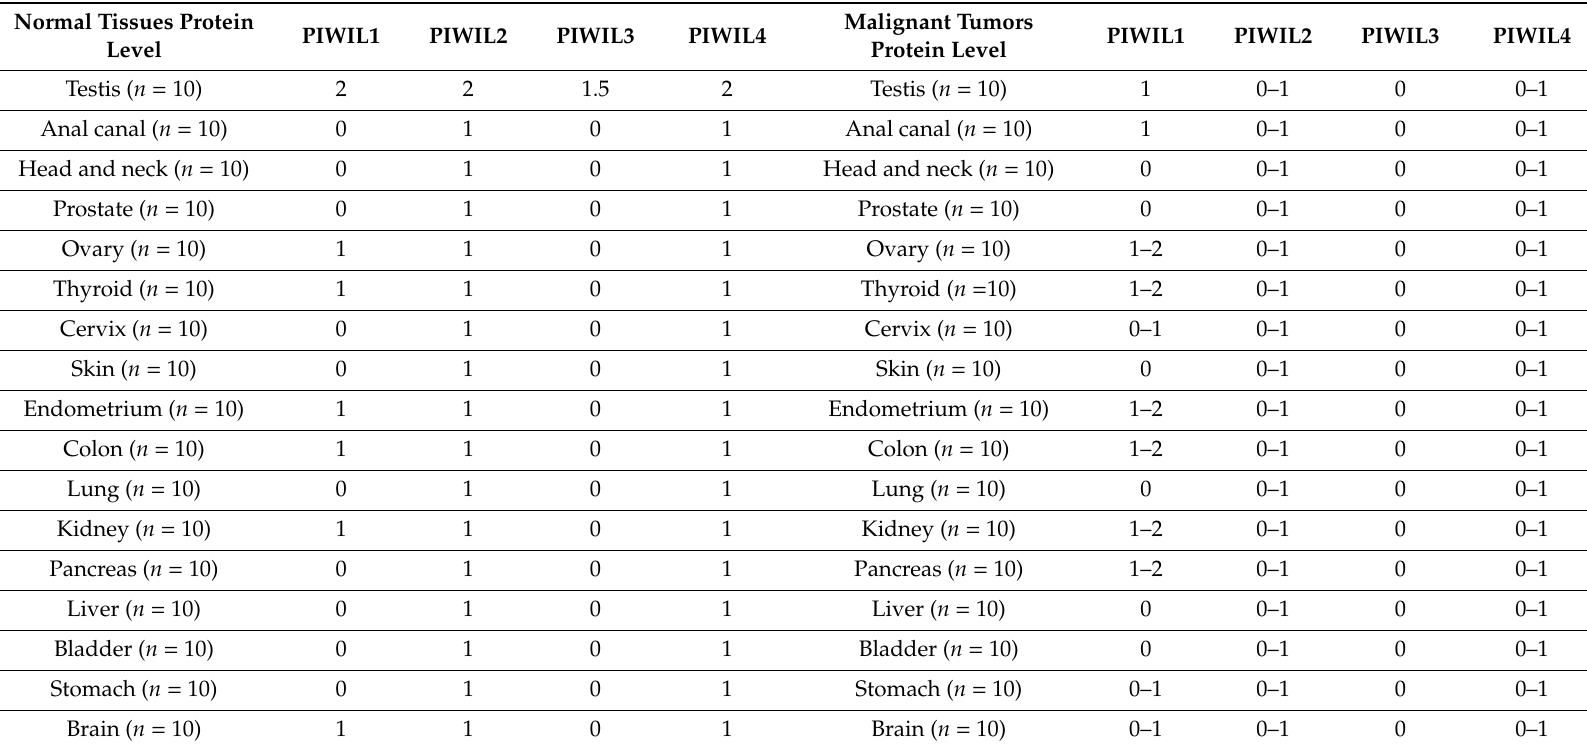
Table 2. PIWIL1-2-3-4 proteins histological score in a multitumor panel ( n = 17) of normal tissues and malignant